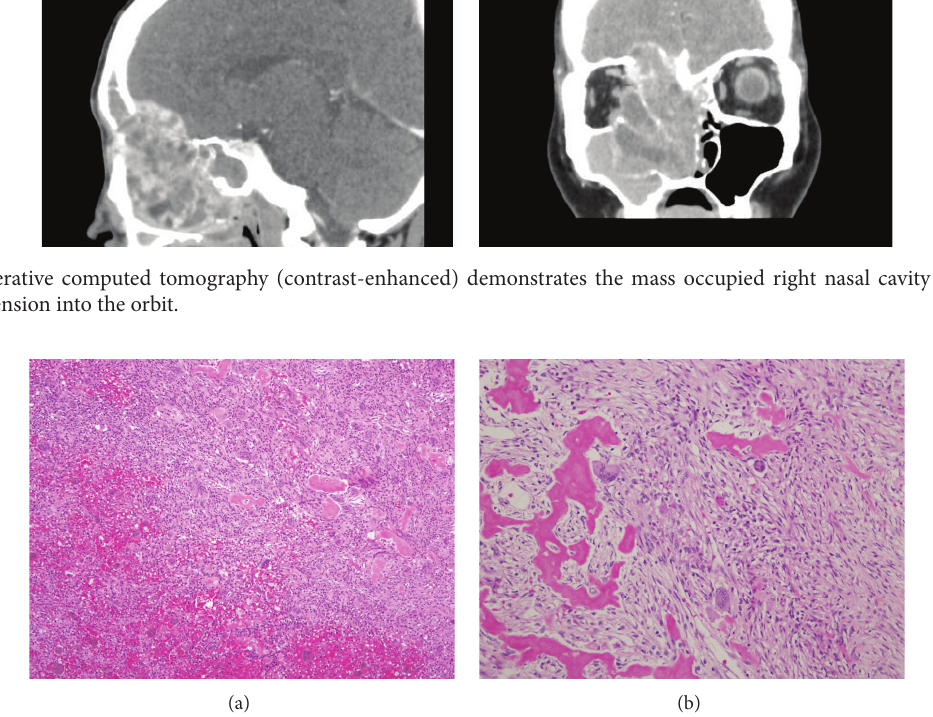
Figure 2: (a) (hematoxylin eosin, original magnification × 20) Granulomatous tissue with numerous characteristic multinucleate giant cells and a large quantity of mononuclear infiltrative cells. (b) (hematoxylin eosin, original magnification × 100) Histopathological examination showed a richly cellular fibroblastic proliferation with osteoclast-likepolynuclear giant cells interspersed with spindle-shaped stroma, spicules of newly formed